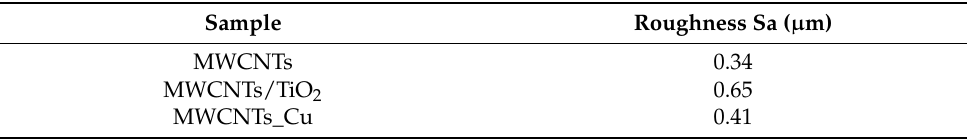
Figure 1. Surface topography for ( A ) the MWCNTs coating, ( B ) the MWCNTs/TiO 2 coating, ( C ) the MWCNTs_Cu coating. Table 3. The surface roughness of the deposited